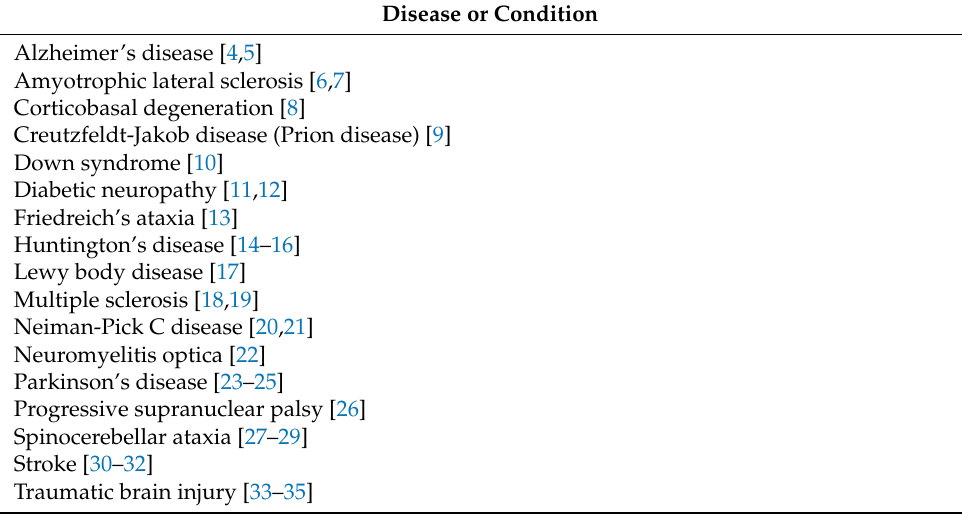
Table 1. Some neurodegenerative diseases and conditions associated with oxidative